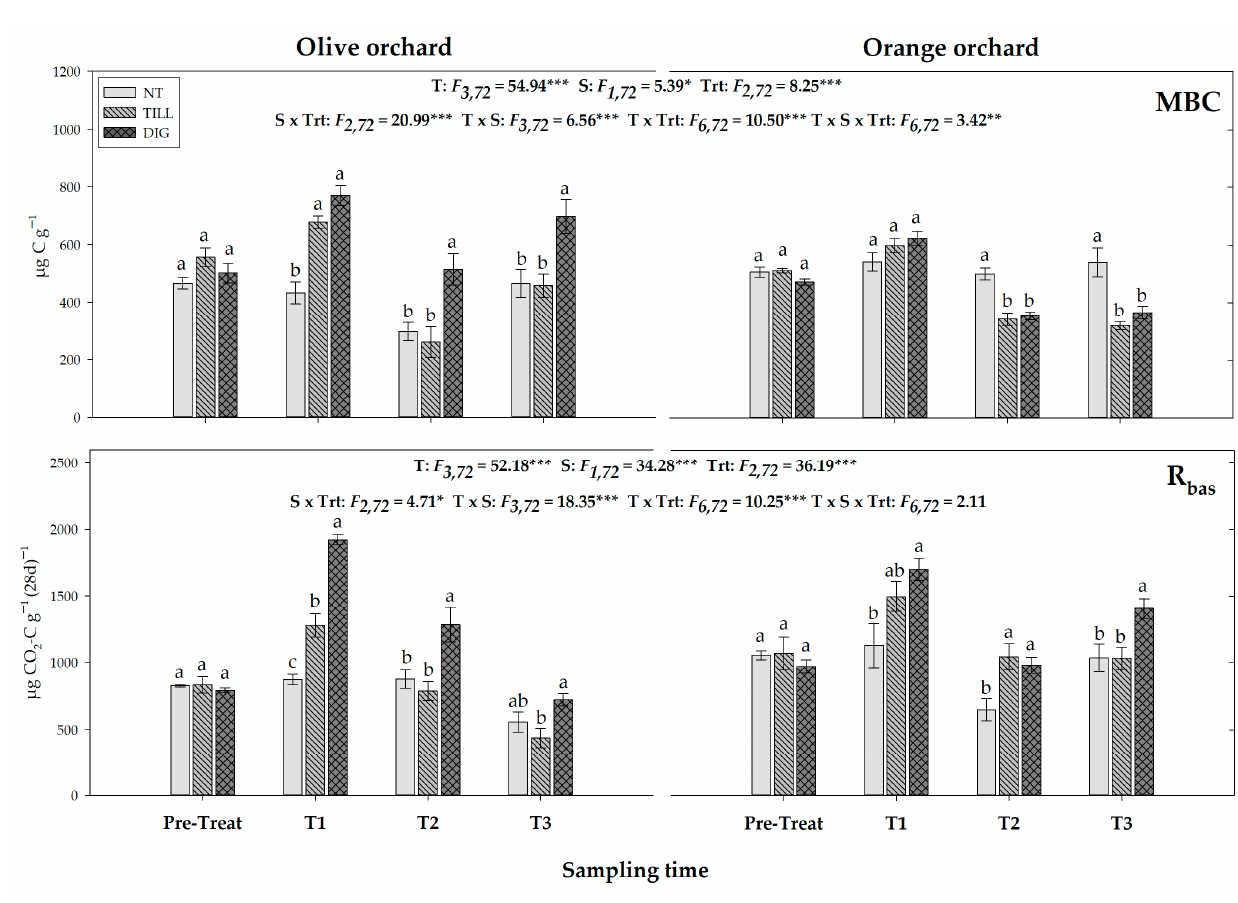
Figure 3. Changes in microbial biomass carbon (MBC) and soil basal respiration (R bas ) (mean ± SD, n = 4) in the field plots arranged in an olive and an orange orchard under different treatments—no-tillage (NT), conventional tillage (TILL), solid anaerobic digestate amendment (DIG)—at four sampling times (from May to September) during the 2016 growing season. Within each sampling period, different letters indicate significant differences among treatments (Tukey’s HSD test, p < 0.05). Significant effects due to time (T), soil type (S), soil management (Trt), and their interactions are presented as F-values, and level of significance (* p < 0.05, ** p < 0.01, *** p < 0.001) was estimated by a three-way ANOVA (time × soil × management).